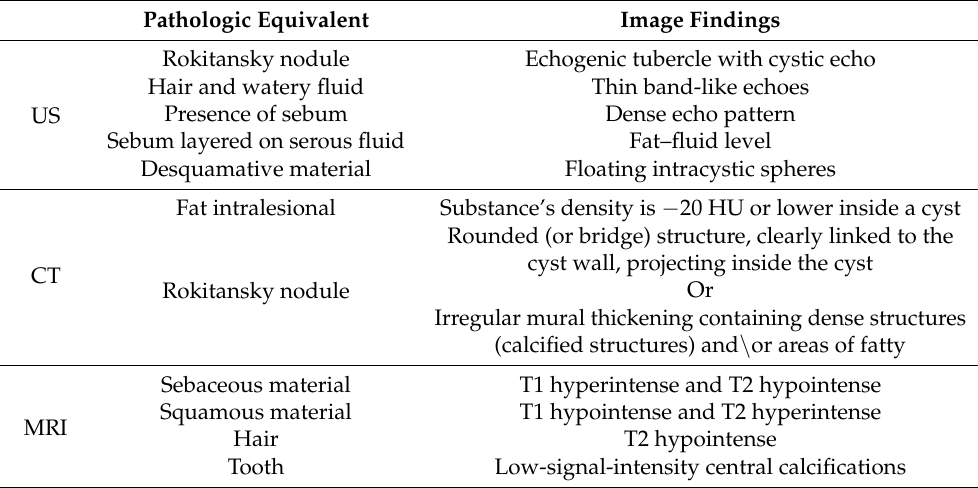
Table 1. Typical image findings of MCTs